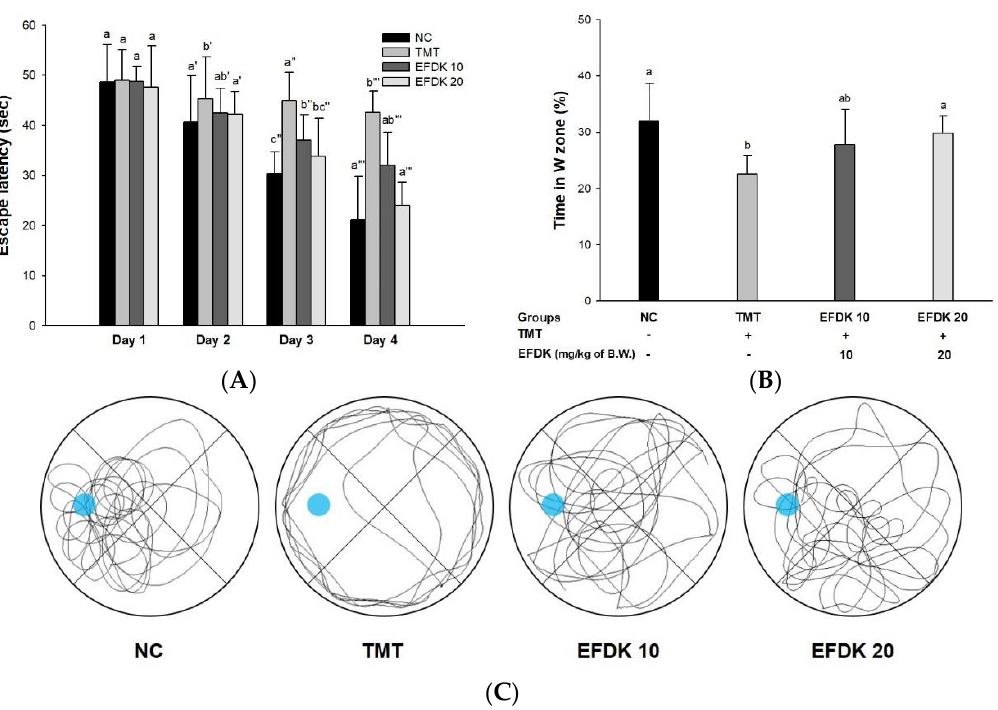
Figure 4. Protective effect of ethyl acetate fraction from persimmon (EFDK) in the Morris water maze test in TMT-induced mice. ( A ) Escape latency in the training trial; ( B ) retention time on W zone in the probe trial; ( C ) path tracing of each groups in the probe trial. Results shown are mean ± SD (n = 8). Data were statistically represented at p < 0.05, and different small alphabets mean statistical significance.